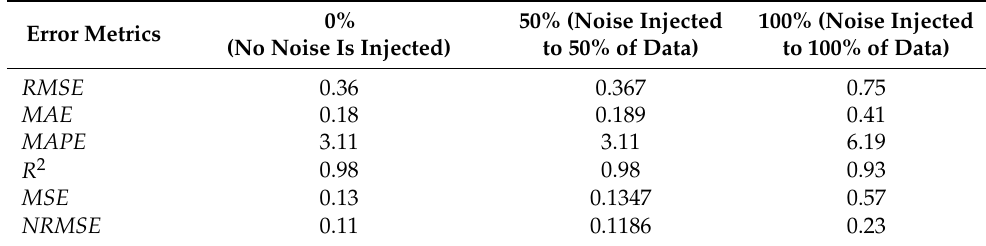
Table 8. Robustness Analysis of the proposed Multi-Step CNN Stacked LSTM Technique with 32 dB